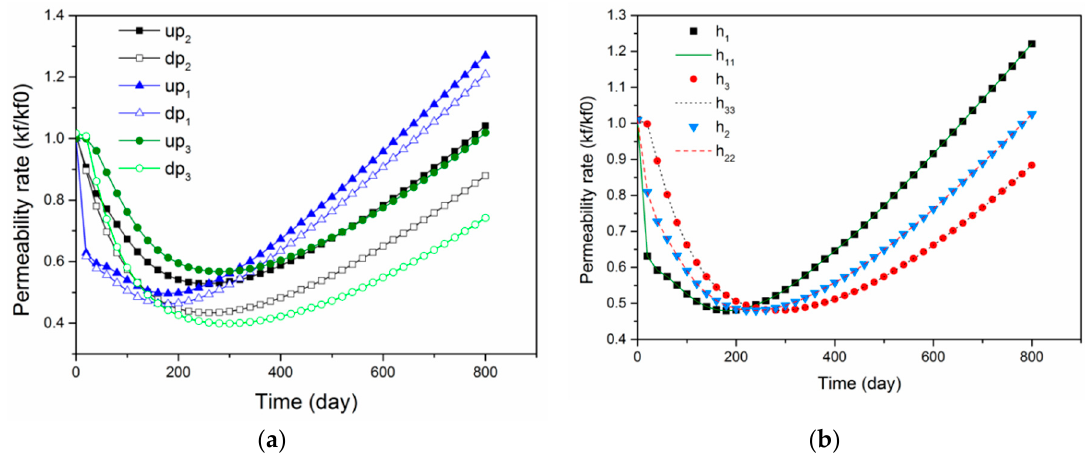
Figure 11. Coal permeability evolution at different points, ( a ) points located on line AB (along the dip of the reservoir), ( b ) points located on line CD (along the strike).